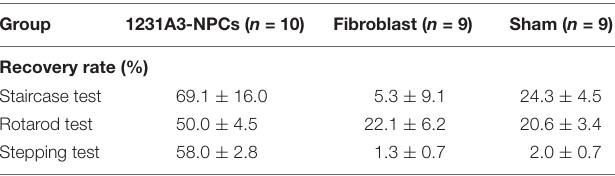
TABLE 1 | Behavioral recovery rates in the 1231A3-NPC TP, fibroblast TP, and sham groups (mean ± SEM